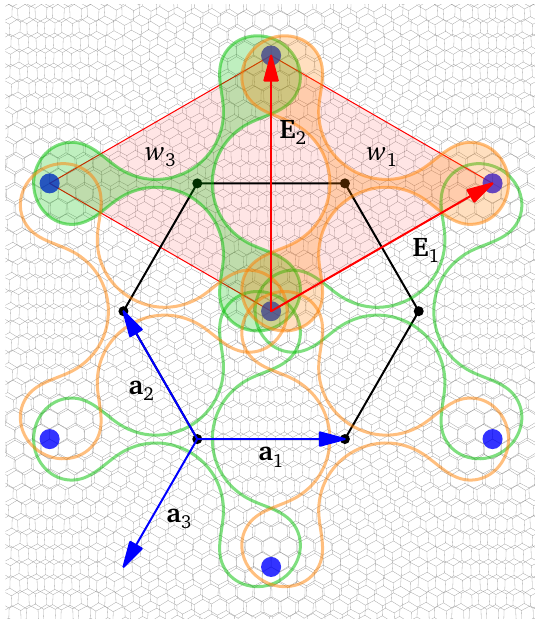
Figure 1: Schematic representation of the Wannier functions w w w (green) on which our model Hamiltonian is built. The charge is maximal at 3 = ∗ 4 the AA superposition points (blue circles) forming a triangular lattice. The Wannier functions are centered on the triangular plaquettes that form a graphene-like lattice (black dots), whose unit cell is shaded in red. The basis vectors E lattice are shown (they are also basis vectors of the graphene-like lattice of Wannier functions), as well as the elementary nearest-neighbor vectors a borrowed from Ref. [ 24 ] and is reproduced here for ease of